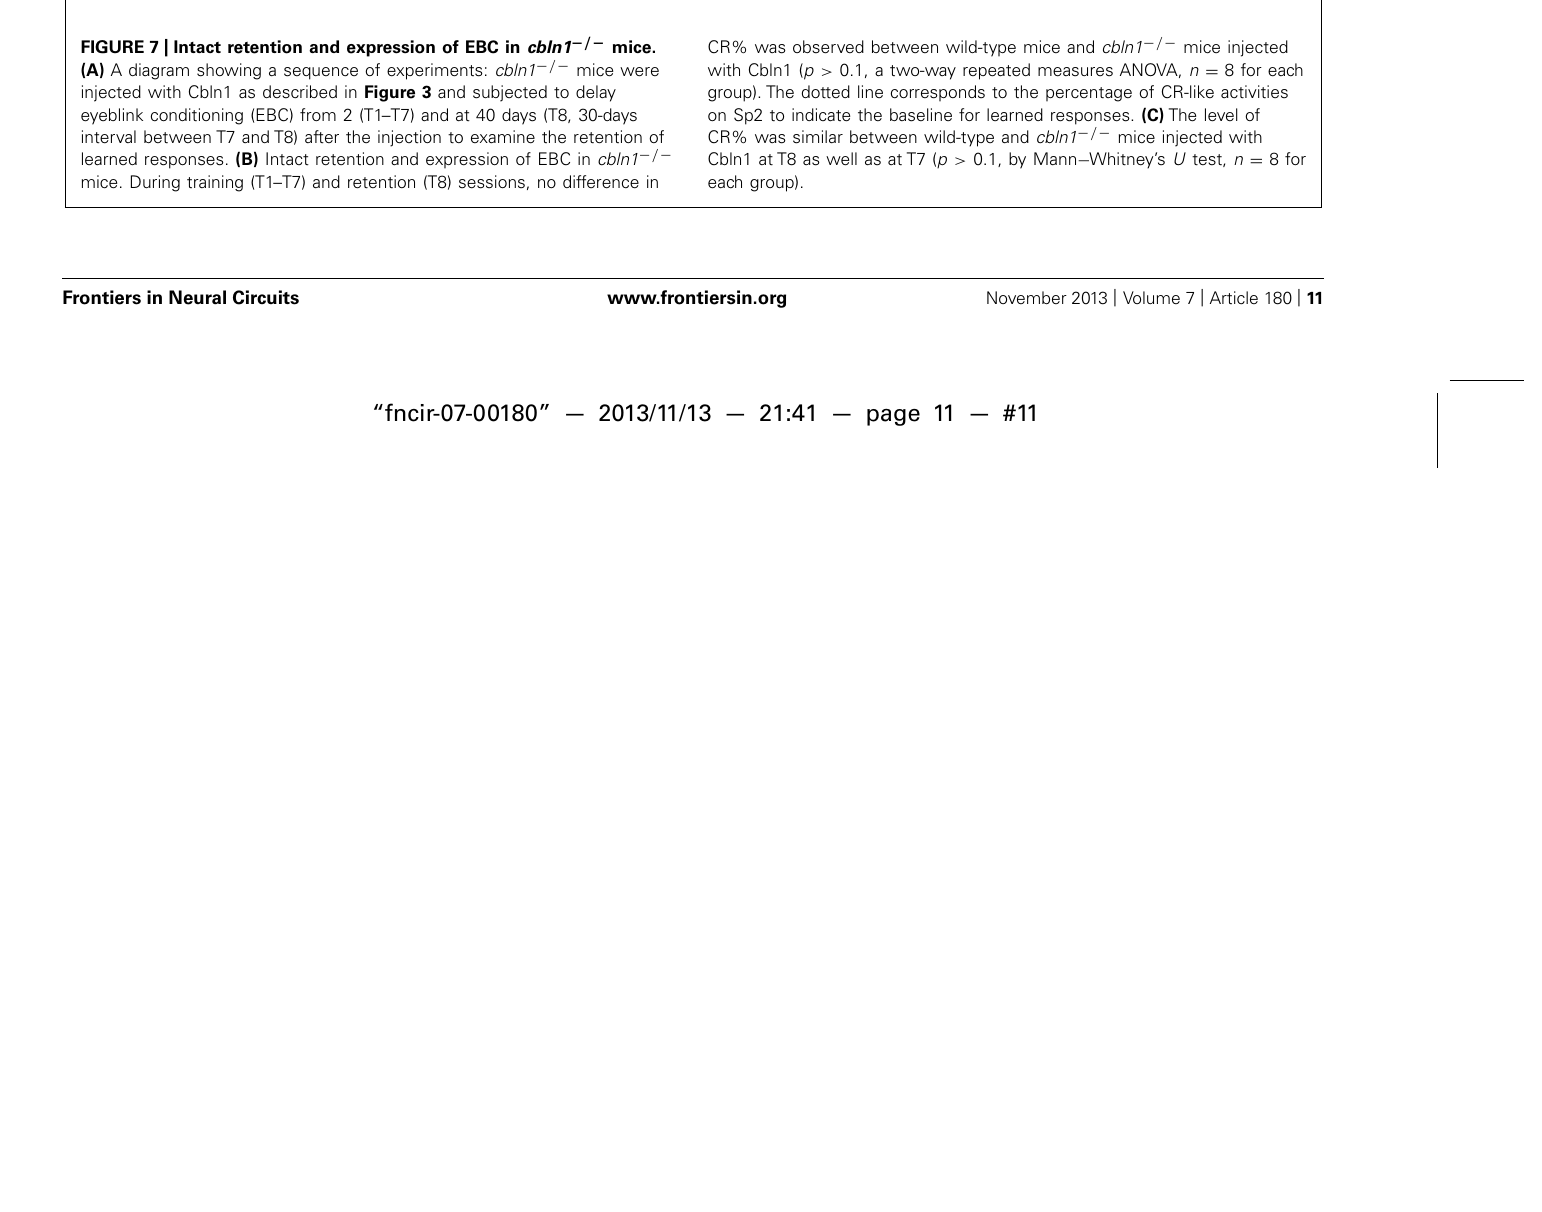
CR% was observed between wild-type mice and cbln1 − / − mice injected with Cbln1 ( p > 0.1, a two-way repeated measures ANOVA, n = 8 for each group). The dotted line corresponds to the percentage of CR-like activities on Sp2 to indicate the baseline for learned responses. (C) The level of CR% was similar between wild-type and cbln1 − / − mice injected with Cbln1 at T8 as well as at T7 ( p > 0.1, by Mann − Whitney’s U test, n = 8 for each